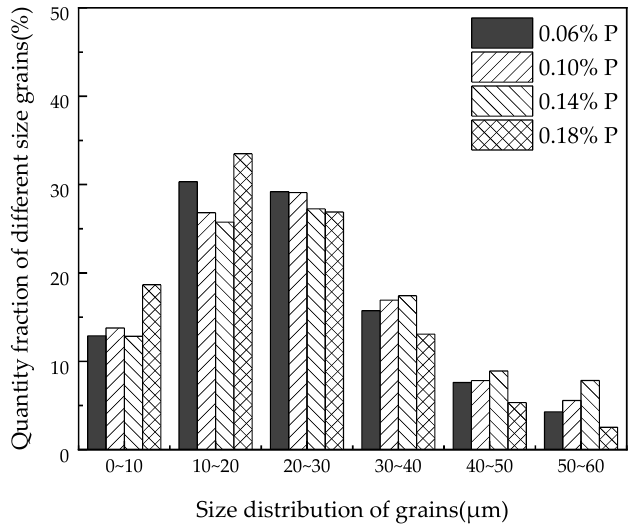
Figure 6. Effect of target P content in the samples on average grain size.